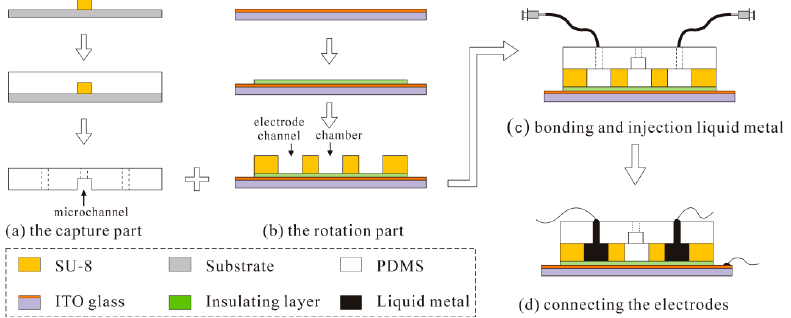
Figure 8. The fabrication process of the biochip. ( a ) The fabrication process of the capture part, ( b ) The fabrication process of rotation part, ( c ) Bonding and injection liquid metal, and ( d ) Connecting the electrodes.